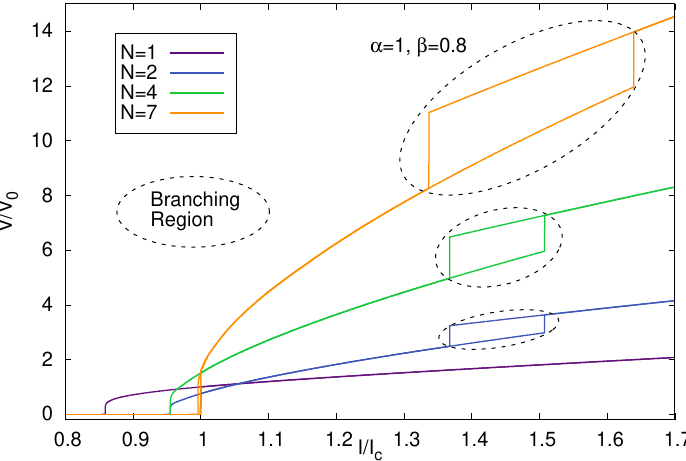
Figure 4. The I-V characteristics for the JJs arrays with different number of junctions in the stack N and the same dissipation of β = 0.8 and the coupling of α = 1. The branching (for arrays with N ≥ 2 junctions) is put in evidence by dashed ellipses.